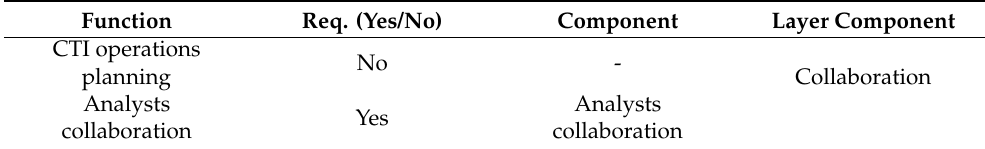
Table 10. Application of CTI Reference Model: Collaboration Layer.